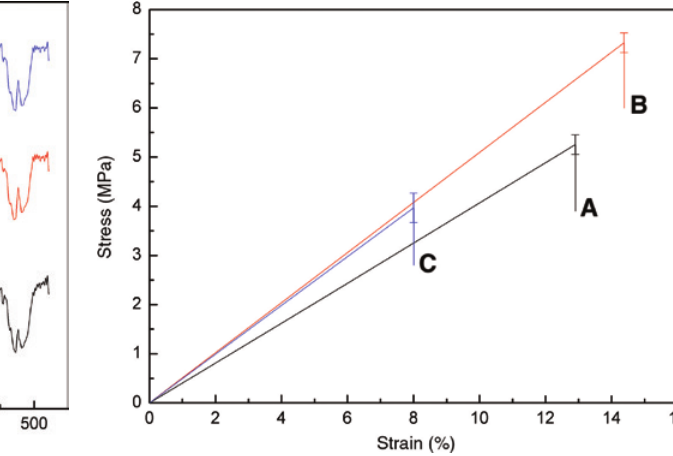
Figure 4: Stress-strain plots of (A) pure PU coating, (B) 2 wt.% SiO /PU 2 composite coating, and (C) 5 wt.% SiO /PU composite coating. 2